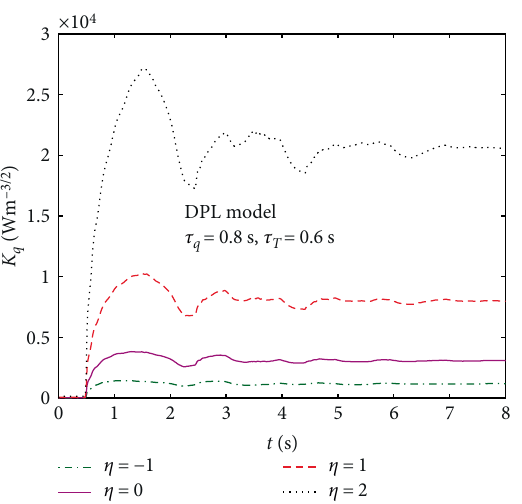
Figure 9: Effect of FG parameter on the temperature history at crack Figure 8: Effect of FG parameter on HFIF based on the DPL face midpoints based on the DPL model. model.